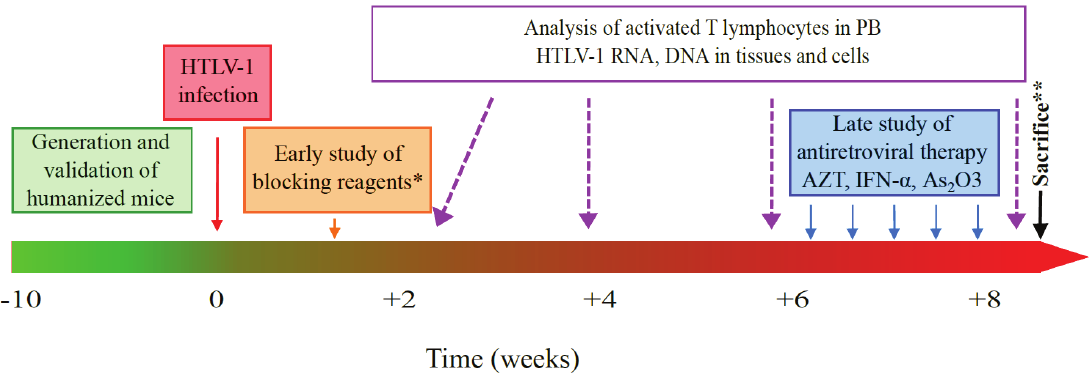
Figure 4. Humanized mice in the development of antiretroviral therapy. A schematic for modeling HTLV-1 infection and therapeutical approaches (orange and blue boxes) in humanized mice. * AZT, NF κ B drugs and/or siRNA; ** analysis of activated T lymphocytes, of HTLV-1 DNA and RNA to evaluate the drug efficiency.